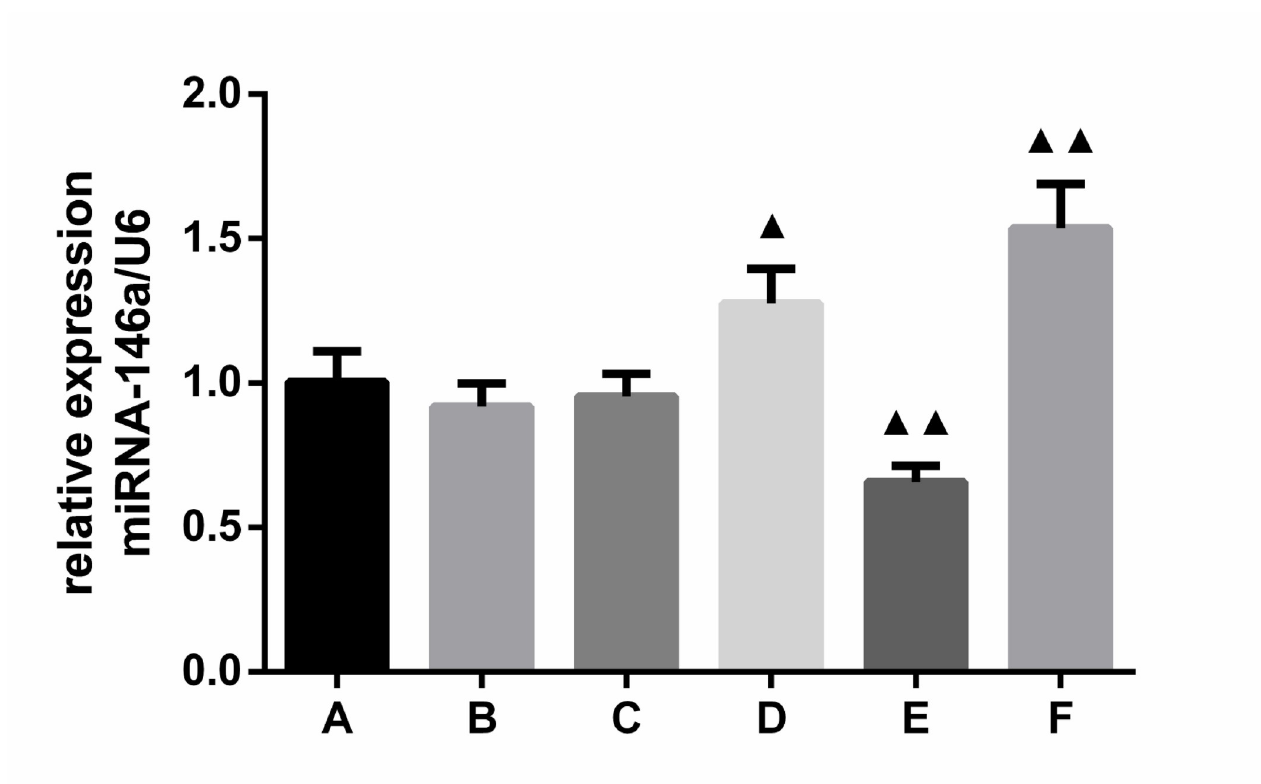
Fig 1. Expression levels of miRNA-146a in THP-1 cells activated by MPA formation ( � x ± s , n = 3). A: negative control; B: miRNA-146a mimics NC; C: miRNA-146a inhibitors NC; D: NF- κ inhibitors; E: miRNA-146a inhibitors; F: miRNA-146a mimics; NC: negative control; MPAs: monocyte-platelet aggregates; ▲ P < 0.05 compared with negative control group, ▲▲ P < 0.01 compared with miRNA-146a inhibitor and mimic NC groups, as analyzed by LSD- t test.